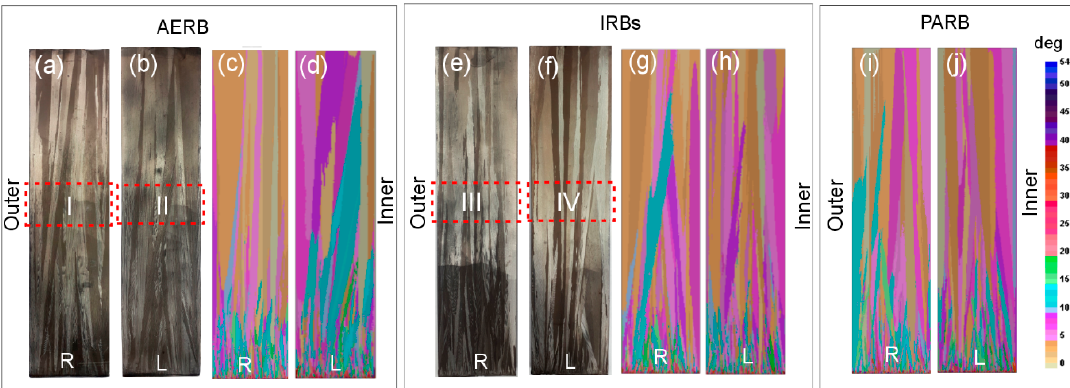
Figure 12. Real ( a , b , e , f ) and predicted ( c , d , g – j ) grain structure at left (L) and right (R) side of casting surface along its height for the process without ( a – d ) or with the use of inner radiation baffles (IRBs) ( e – h ) or perfectly adjusted radiation baffle (PARB) ( i , j ), where I–IV are areas of detailed analysis of grain and dendrite microstructure. AERB: adjusted external radiation baffle. Materials 2019 , 12 , x FOR PEER REVIEW 18 of 22